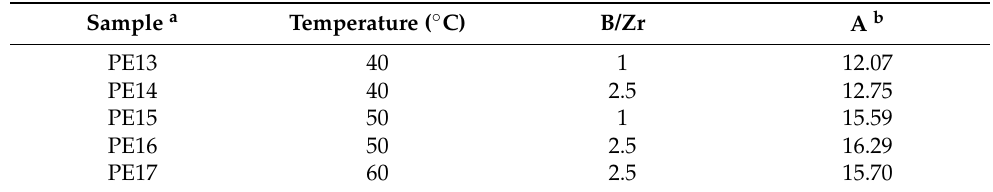
Table 5. Reaction parameters and general features of the synthesized PEs using CP 2 Zr(CH 3 ) 2